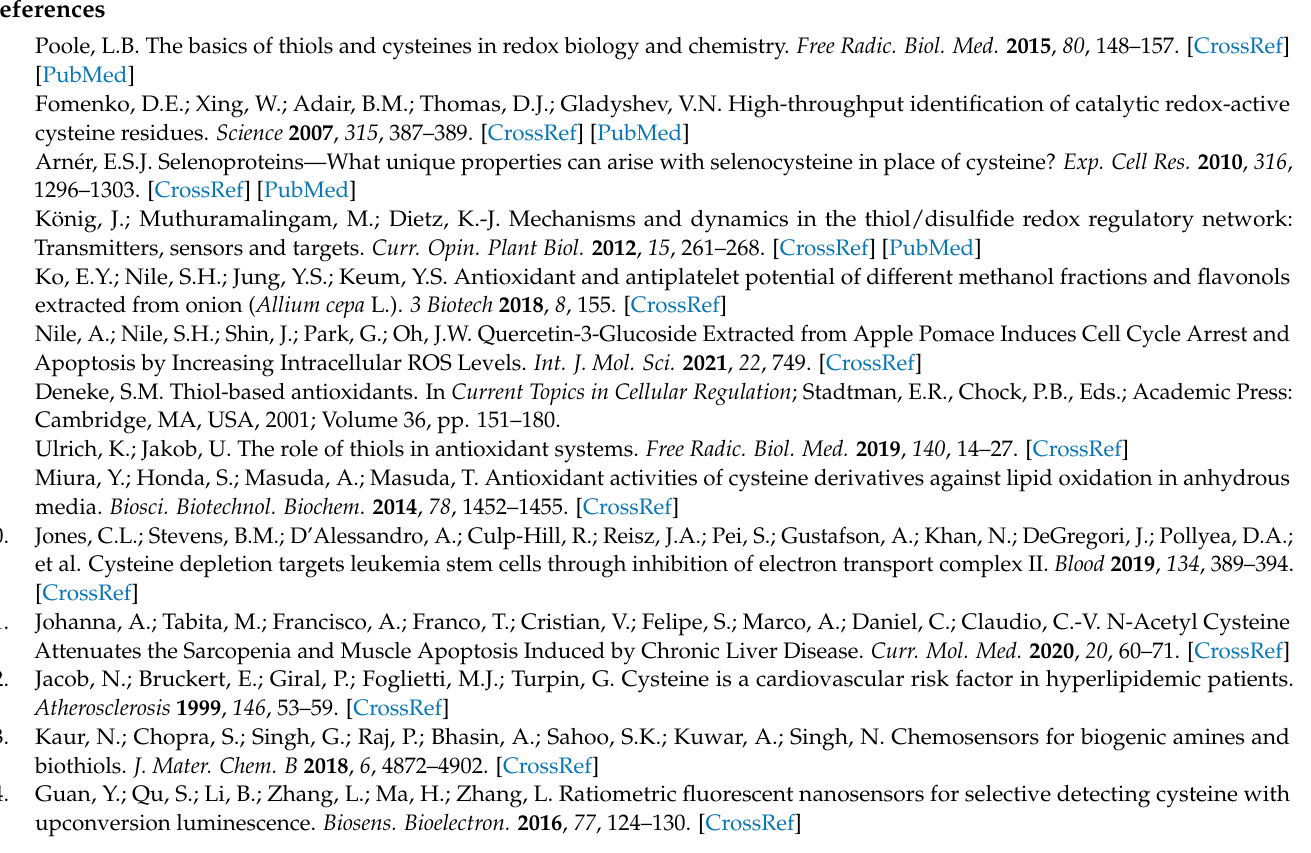
3 , Figure S2: 13 C NMR spectrum of compound 3 , Figure S3: Mass spectrum of compound 3 , Figure S4: 1 H-NMR spectrum of A-B , Figure S5: 13 C NMR spectrum of A-B , Figure S6: Mass spectrum of A-B , Figure S7: Image taken under UV lamp depicting the selectivity of A-B for Cys among other amino acids. The addition of Cys (50 µ M) to the solution of A-B (10 µ M) results in fluorescence turn-on